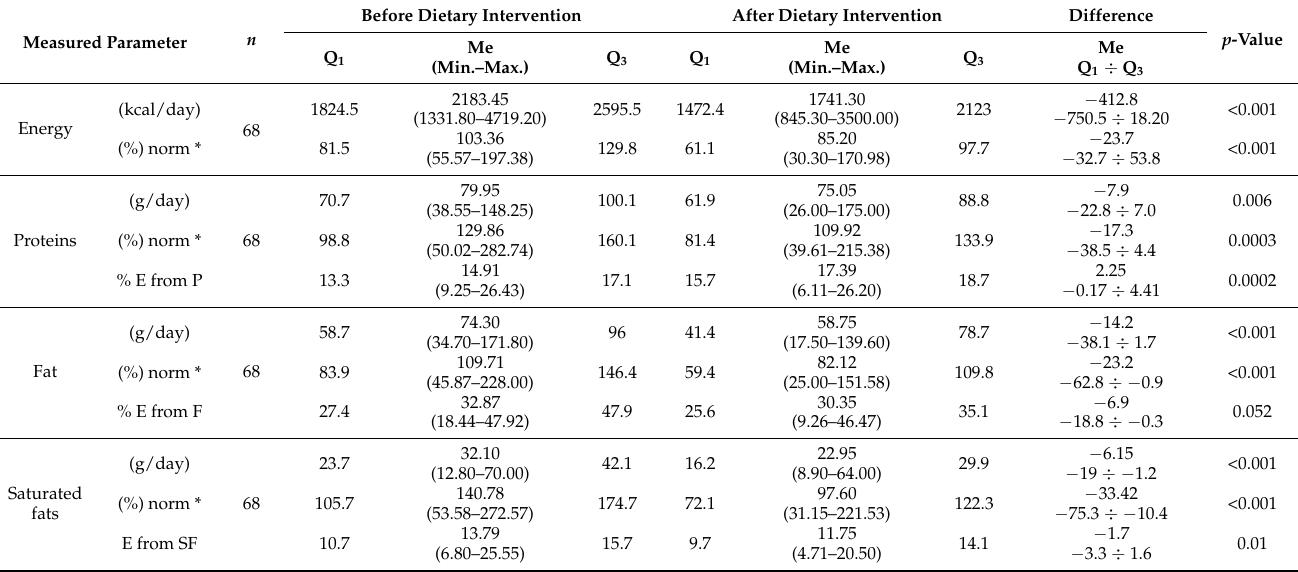
Table 5. The effect of one-year dietary education on the consumption of energy and chosen macronu- trients by children in the study